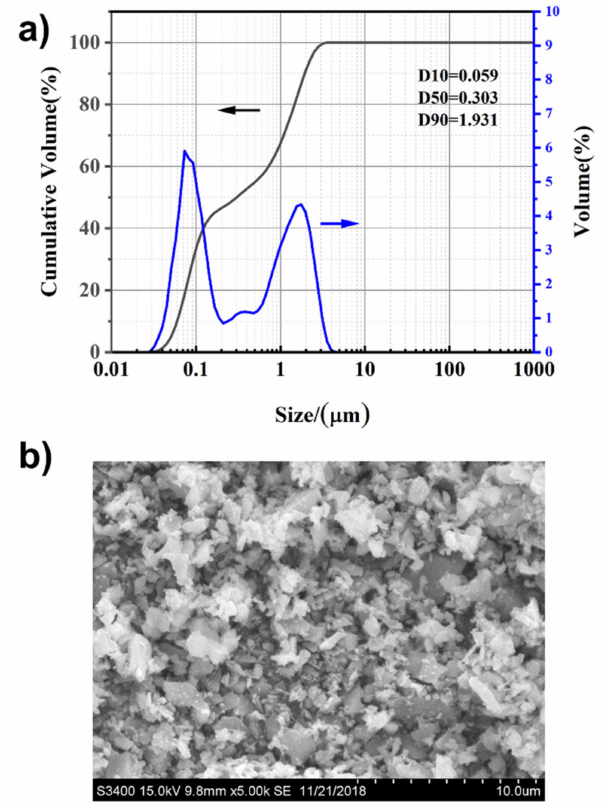
Figure 3. Particle size distribution of the as-received SiC powder ( a ) and scanning electron microscopy (SEM) image of the as-received SiC powder ( b